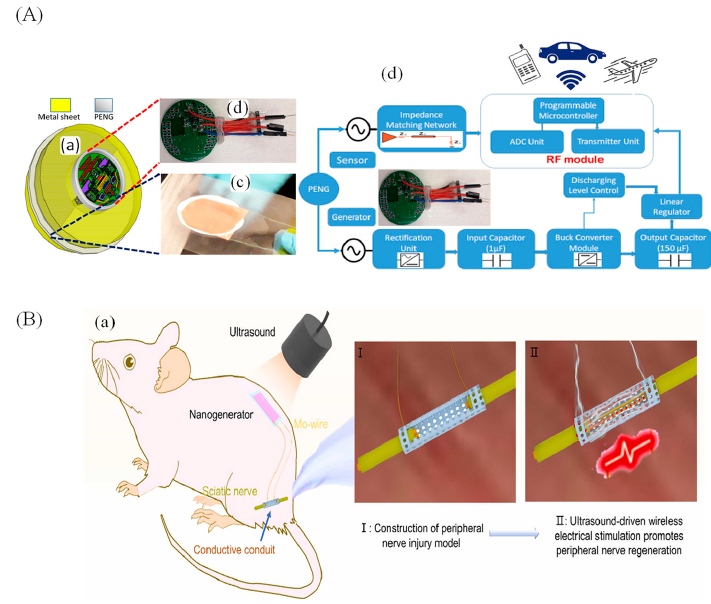
Figure 11. ( A ) Wireless sensor based on a porous PVDF-based PENG. ( a ) Functional component of the fabricated sensor, which was made up of porous PVDF-PENG and an integrated circuit unit. ( b ) Actual image of the fabricated device. ( c ) Actual image of a fabricated porous PVDF device. ( d ) Block diagram of the entire sensing system [128]. Adapted with permission from Rana et al. (2020) Copyright © 2020 American Chemical Society ( B ) Graphical representation of implant in a rat. ( a ) In vivo electrical simulator in a rat based on a PHBV/PLLA/KNN film nanogenerator with the com- bined use of ultrasound to enhance peripheral nerve repair [129]. Adapted with permission from Wu et al. (2022). Copyright © 2022 Elsevier.